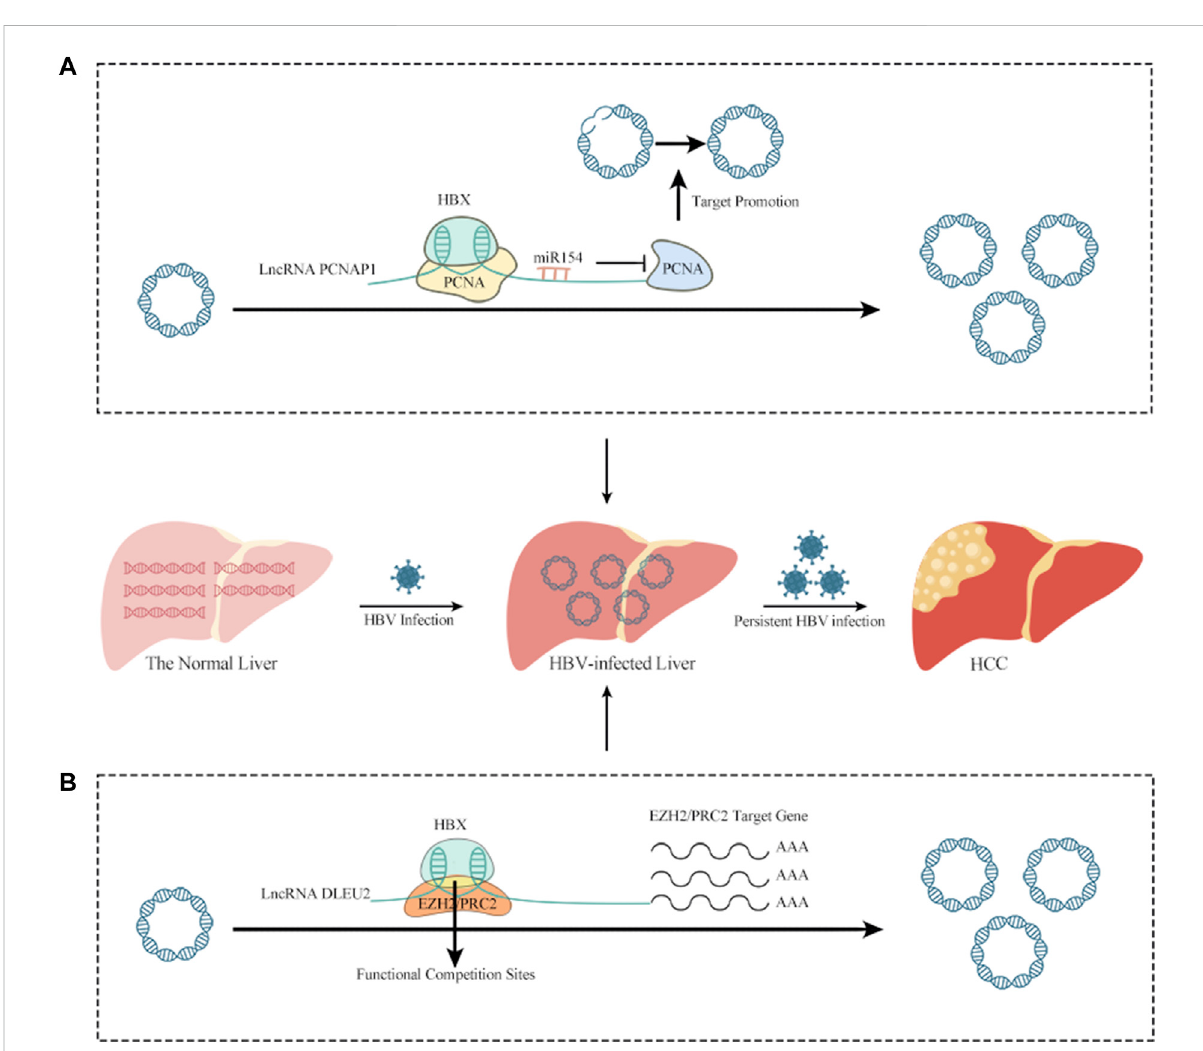
FIGURE 1 The relationship between lncRNAs and HBV infection of HCC. (A) PCNAP1 sponges miR-154, promoting expression of hepatic PCNA, which is required for cccDNA formation and is involved in DNA replication, repair, RNA modi fi cation, and chromatin remodeling. PCNA then binds to HBc, enabling anchorage to the cccDNA mini-chromosome and subsequent vital replication and cccDNA accumulation. (B) In HBV-infected cells, HBx binds to the lncRNA DLEU2 promoter, promoting DLEU2 transcription and its subsequent accumulation in infected hepatocytes. Blocking the repressive function of EZH2/PRC2 and activating transcription leads to the transcription and replication of cccDNA in HBV-related HCC, together with the transcriptional activation of genes downstream of EZH2/PRC2 and, ultimately leading to